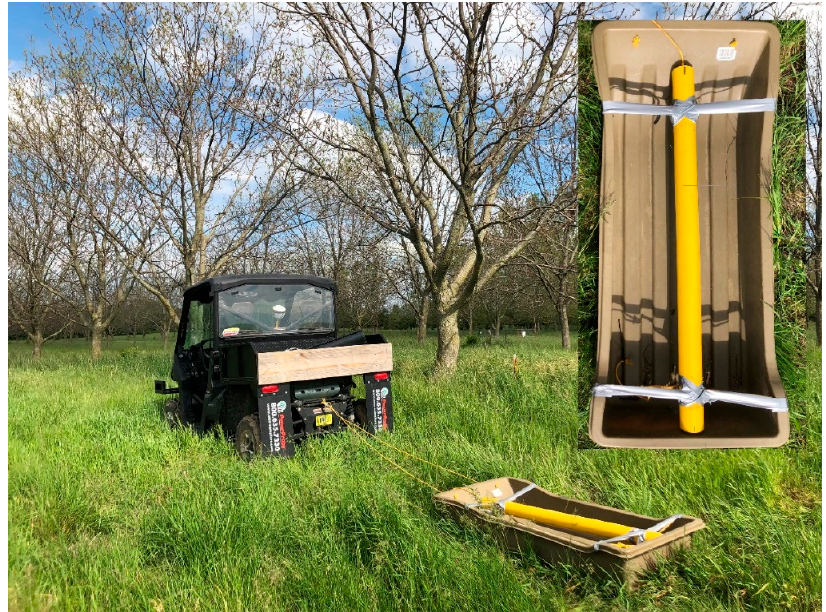
Figure 2. The apparent electrical conductivity (EC a ) survey setup included a DUALEM-1S sensor (DUAL-geometry Electro-Magnetic; Dualem Inc., Milton, ON, Canada) that was suspended on a sled and tied to a Side-by-Side vehicle, and a Trimble R2 global positioning system unit (Trimble Inc., Westminster, CO, USA) mounted inside of the Side-by-Side; both the DUALEM-1S and Trimble R2 were connected to a Trimble Yuma 2 field computer inside the Side-by-Side that interpolated the data in a hand-held geoinformation system.